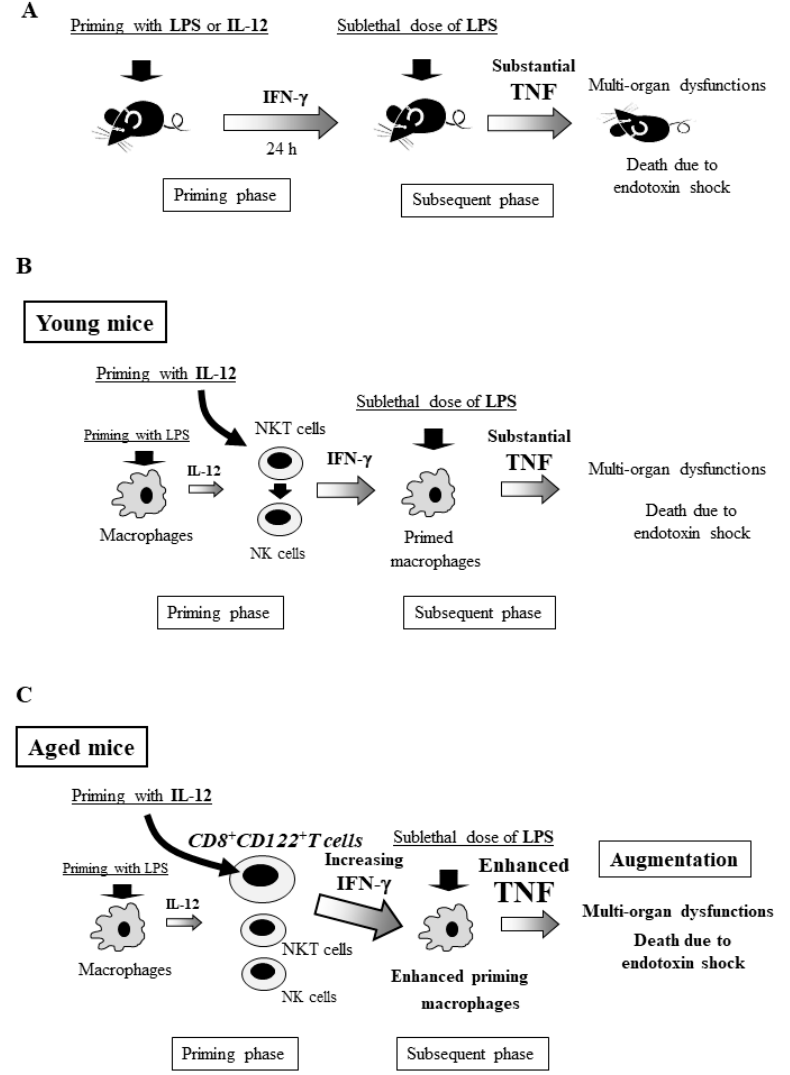
Figure 1. The generalized Shwartzman reaction induced by interleukin (IL)-12 priming and subsequent lipopolysaccharide (LPS) challenge. ( A ) Priming with LPS or IL-12 induces IFN- γ production in mice, and 24 h later, subsequent LPS challenge induces substantial tumor necrosis factor (TNF) production, resulting in the generalized Shwartzman reaction. ( B ) In young mice, IL-12 priming activates natural killer (NK) and natural killer T (NKT) cells to produce IFN- γ , which primes macrophages. Subsequent LPS challenge strongly activates the primed macrophages to produce large amounts of TNF, resulting in the generalized Shwartzman reaction. ( C ) In aged mice, age-dependently increased IL-12-activating CD8 + CD122 + TcellsaugmentIFN- γ production, resultinginthefurtherenhancementofTNFproduction by macrophages and leading to increased lethality of the generalized Shwartzman reaction. Figures are revised from